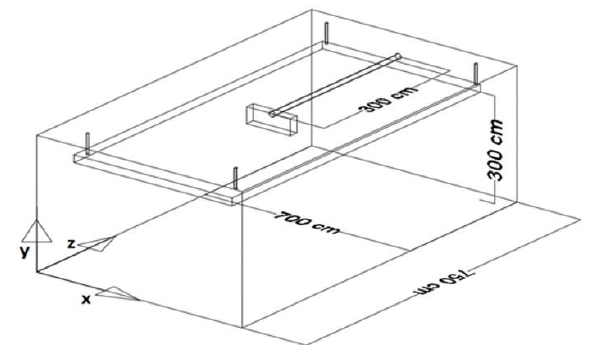
Fig. 1 . Dimensions of the laboratory test section.